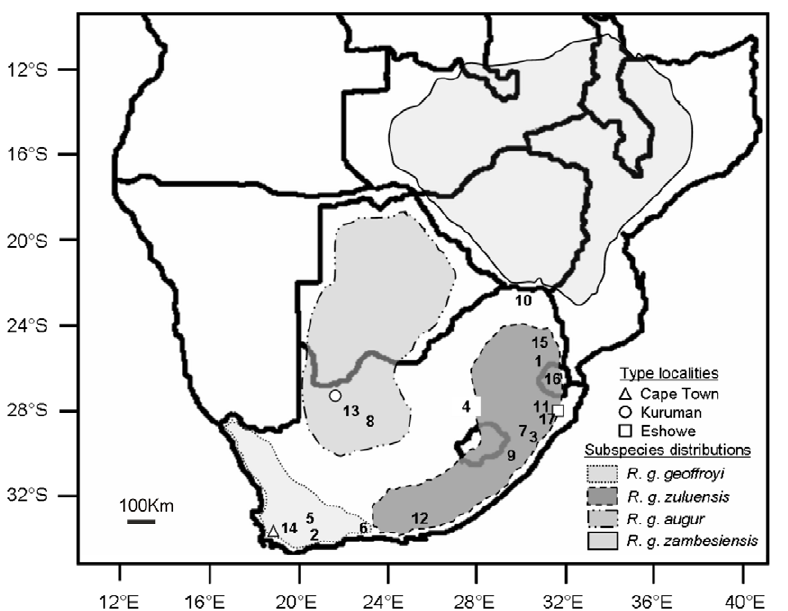
Figure 1. Rough distributions of the four R.geoffroyi subspecies as described in Roberts [ 28 ] . Type localities for three subspecies and the sampling sites used in this study are indicated where 1) Barberton, BT; 2) De Hoop, DHC; 3) Ferncliffe, FCC; 4) Winburg, FS; 5) Greyton, GREY; 6) Knysna, HKV; 7) Hopewell Farm, HWF; 8) Koegelbeen, KGB; 9) Kokstad, KSM; 10) Lajuma, LAJ; 11) Melmoth, MEL; 12) Maitland Mines, MM; 13) Postmasburg, POST; 14) Stellenbosch, STEL; 15) Sudwala, SUD; 16) Swaziland, SWZ; and 17) Yolland, YOL. The type locality for R. g. zambesiensis is only given as South Rhodesia, corresponding to present-day Zimbabwe.